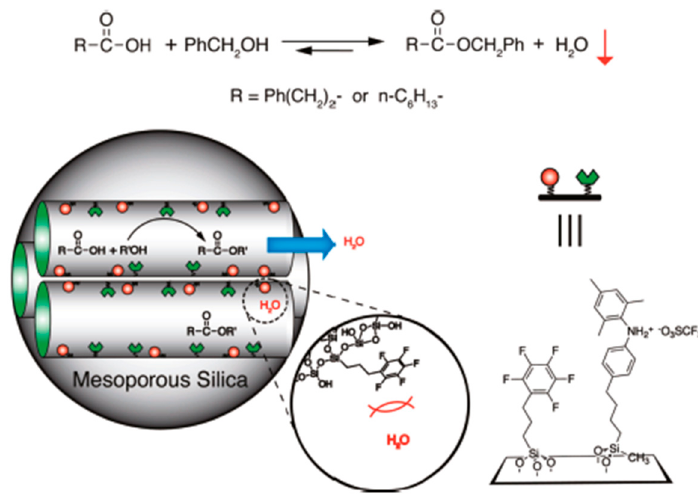
Figure 21. Schematic representation of a bifunctional pentafluorophenyl propyl (PFP)/DAT-MSN. Reproduced with permission from [29]. Copyright 2011 American Chemical Society.